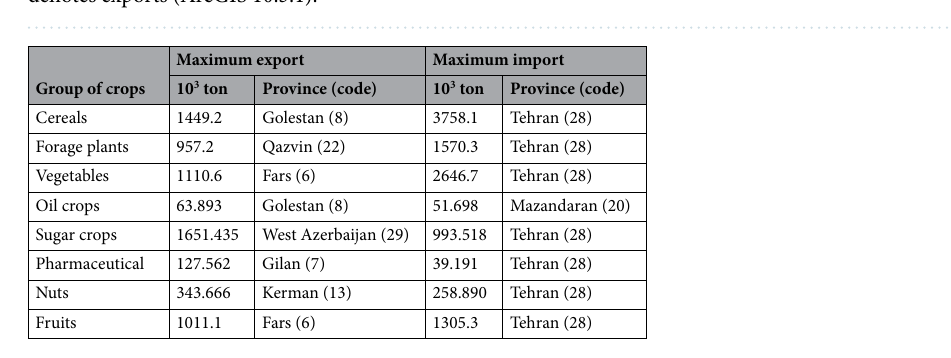
Table 1. Leading exports and imports by crop group. The province codes refer to the provinces shown on the map in Fig.